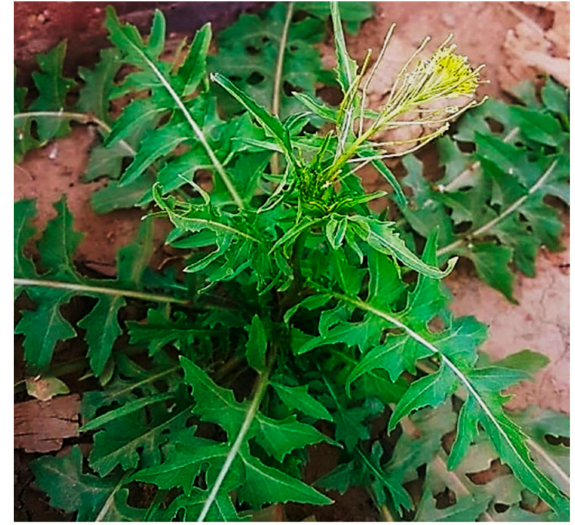
Figure 1. Saudi Arabian desert seasonal plant of Sisymbrium